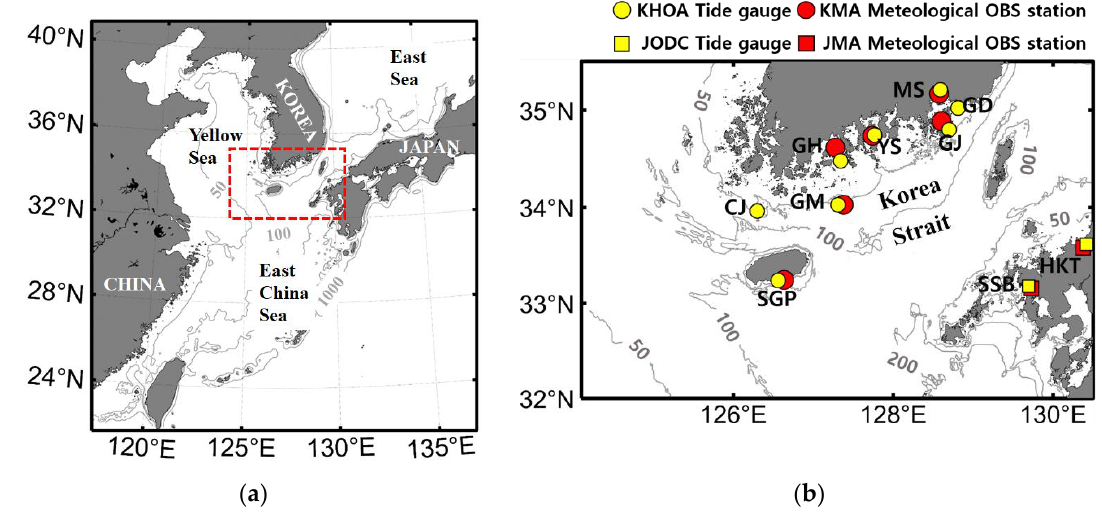
Figure 1. ( a ) The red dashed rectangle represents the study area covering the Korea Strait between the Yellow Sea, East China Sea, and East Sea. ( b ) Observation stations for atmospheric pressure (red) and sea level (yellow) in the Korea Strait. CJ, SGP, GM, GH, YS, GJ, GD, MS, SSB, and HKT stand for Chujakdo, Seogwipo, Geomundo, Goheung, Yeosu, Geojedo, Gadeokdo, Masan, Sasebo, and Hakata, respectively. Contours represent the bottom topography (m). Jeju Island and Tsushima Island are located at 126.8° E, 33.4° N and 129.5° E, 34.5° N, respectively, in the Korea Strait. MS is located in Jinhae-Masan Bay (128.4–128.8° E, 34.9–35.3° N).